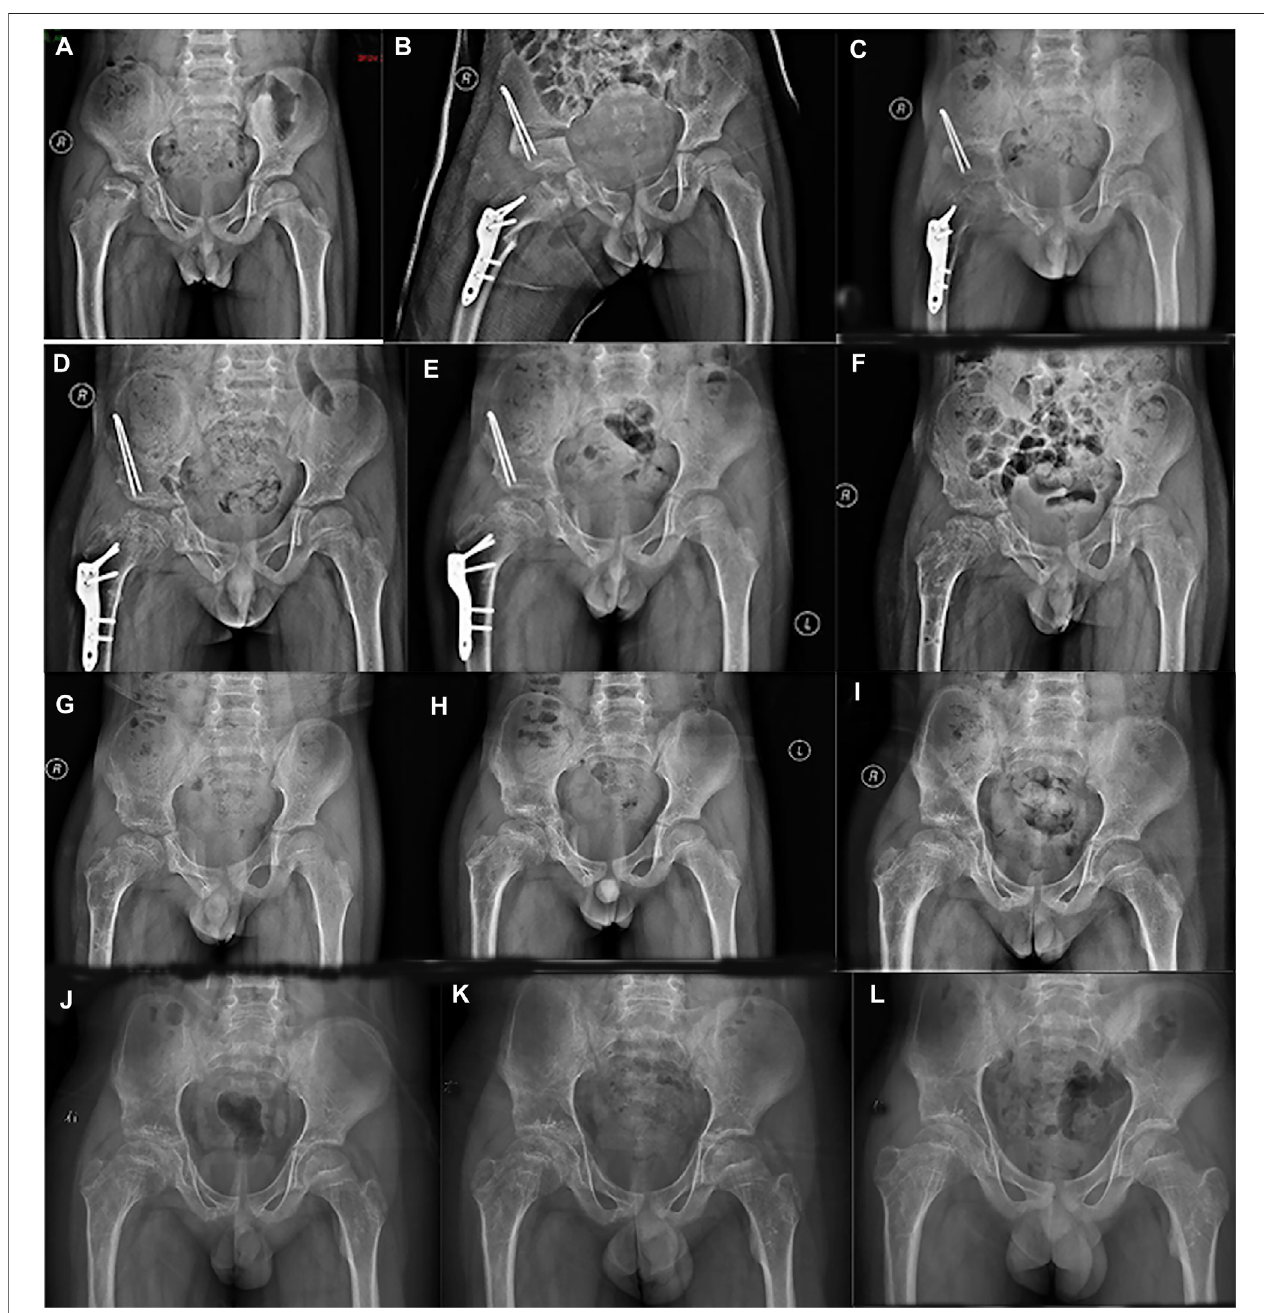
FIGURE1| SeriesradiographsofpelvisfromaboywithPerthesdiseasepresentation. (A) Pelvicradiographofa7.5 yearsoldboy(March2016). (B) Postoperative pelvic radiograph (March 2016). (C) . 4 months after operation (July 2016). (D) . 7 months after operation(October2016). (E) 11 monthsafter operation (February 2017). (F) .12 monthsafterprimaryoperation,and1 monthafterimplantremoval(March2017). (G) 3 monthsafterimplantremoval(April2017). (H) 1 yearafterimplantremoval (March2018). (I) 2 yearsafterimplantremoval(January2019). (J) 3 yearsafterimplantremoval(November2019). (K) 4 yearsafterimplantremoval(October2020). (L) 5 years after implant removal (January